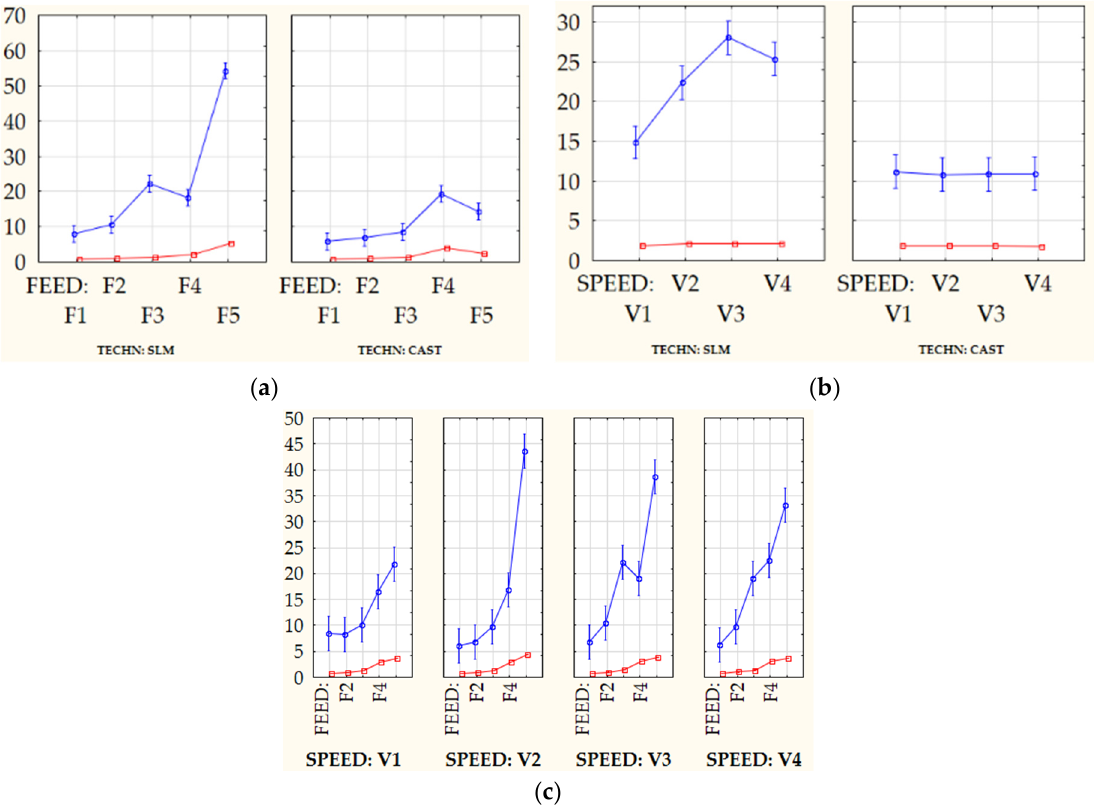
Figure 10. Significant interactions affecting the values of Sa and Sz parameters determined using multivariate ANOVA analysis where: ( a ) the impact of interaction between the semi-finished product technology and feed (TECH × FEED), ( b ) technology and cutting speed (TECH × SPEED) and ( c ) feed and cutting speed (FEED × SPEED).